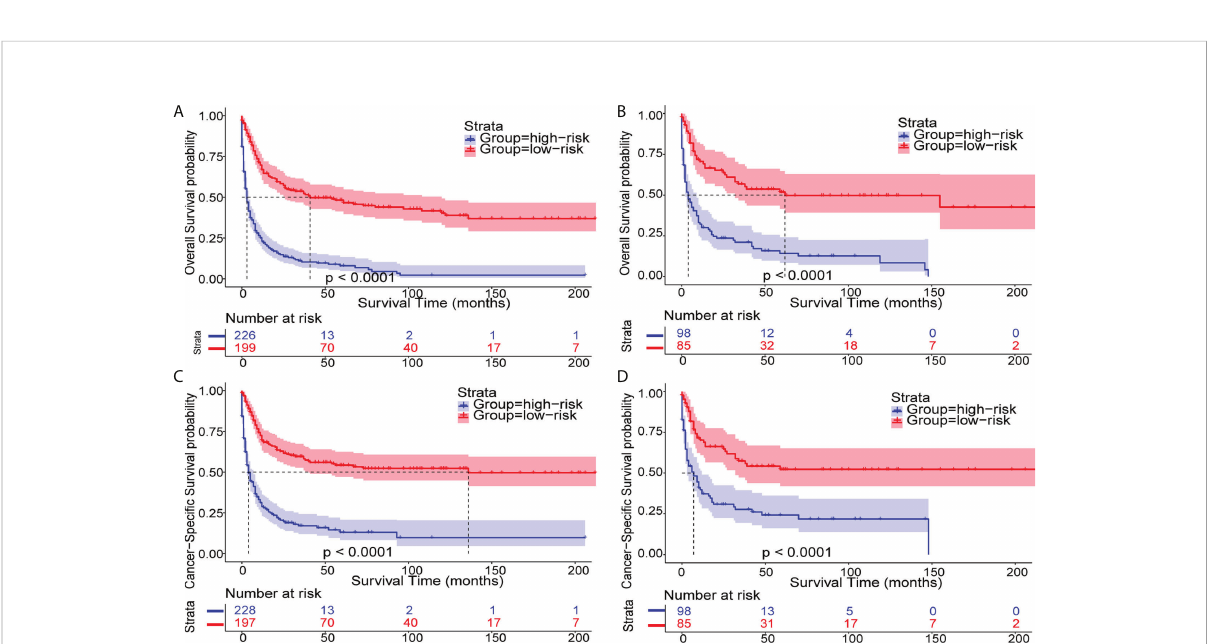
FIGURE 7 Kaplan – Meier analysis of OS and CSS in patients with eMS. Kaplan – Meier survival curves of OS and CSS in eMS patients strati fi ed by risk levels in the training cohort (A, C) and validation cohort (B, D)